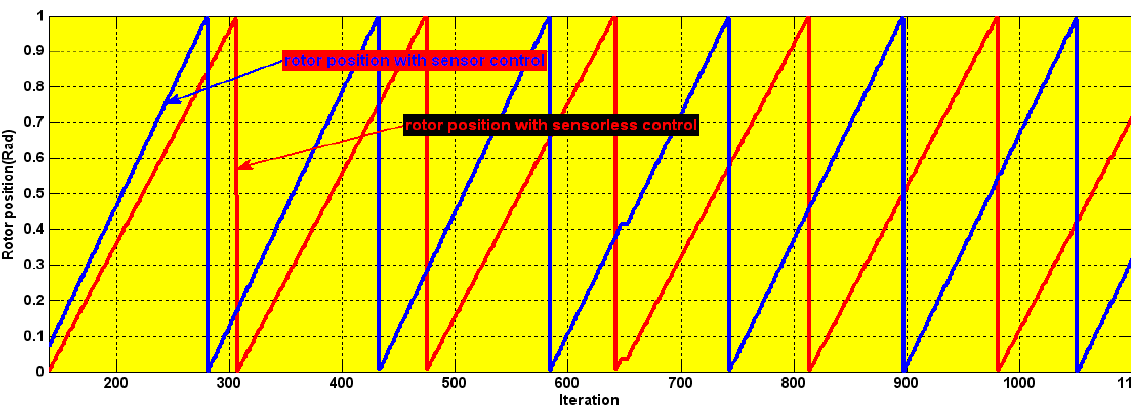
Figure 24. Experimental rotor position with partial sensing error.